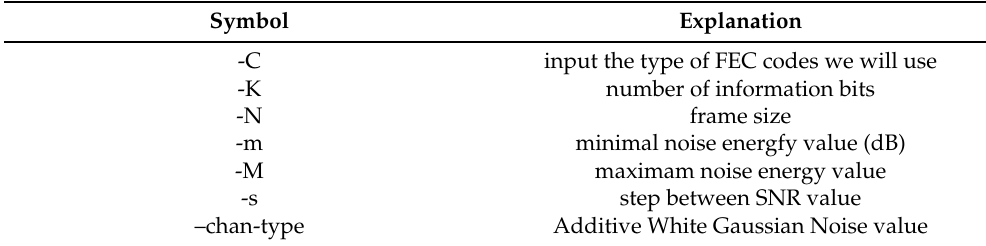
Table 1. Nomenclature.